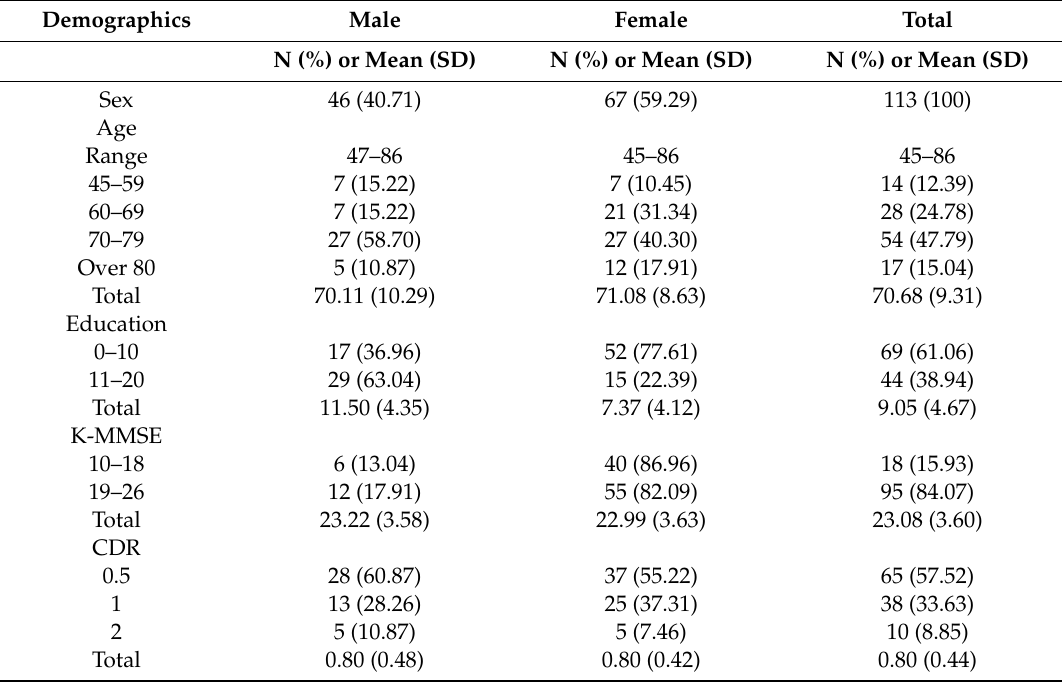
Table 2. Demographic information of study